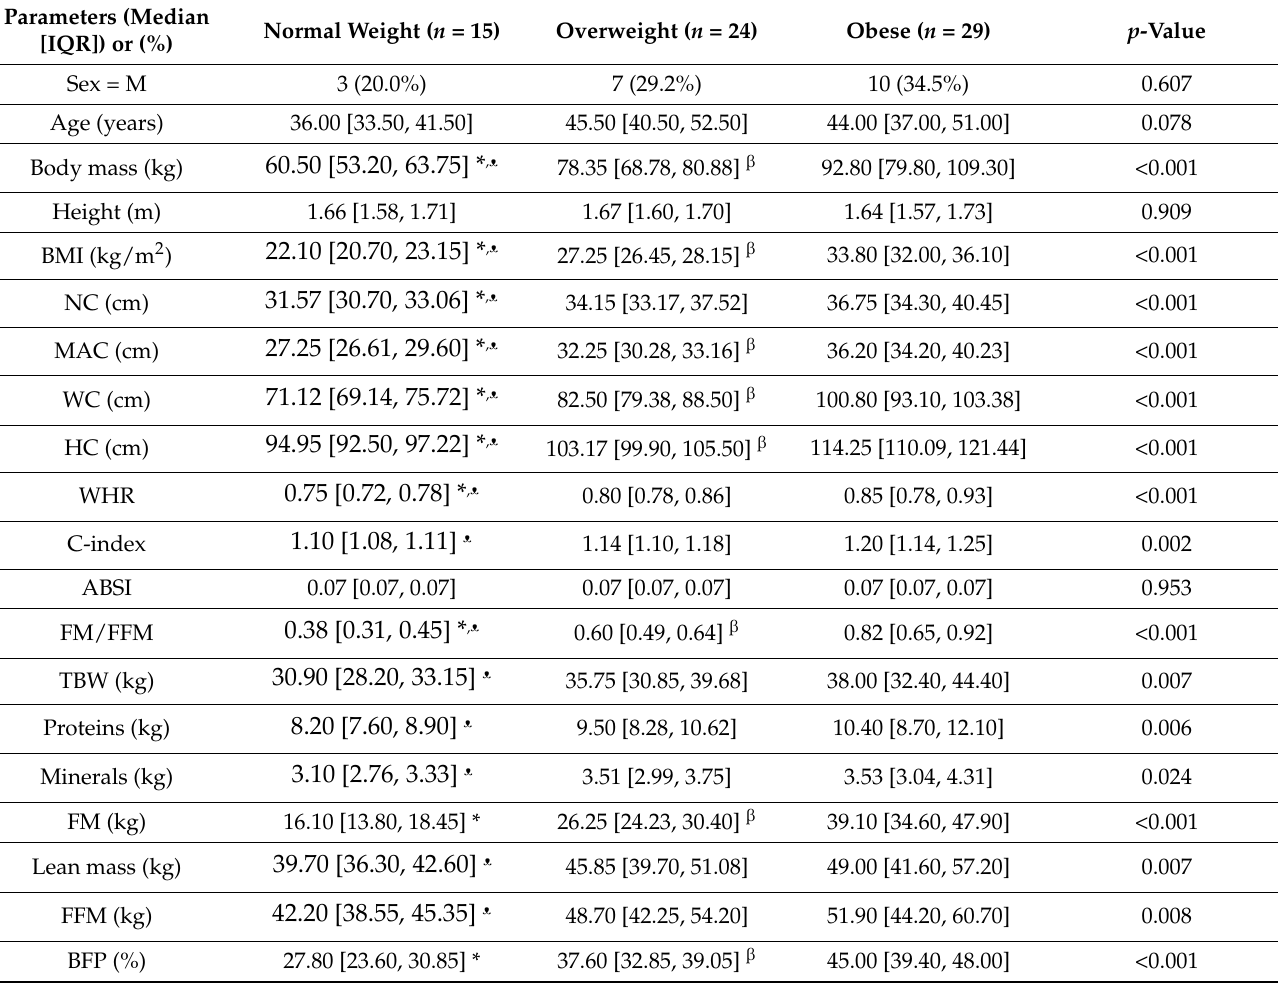
Table 1. General characteristics of the individuals.